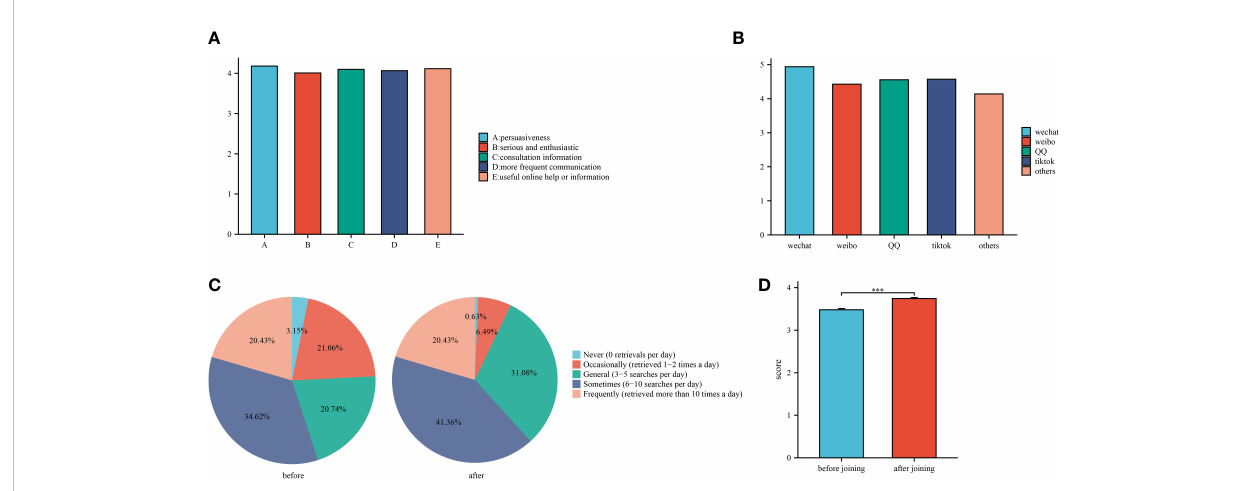
FIGURE 4 (A) : Scores for different online information exchange behavior; (B) : Score for different app usage frequency. (C) : Proportion of active search frequency before and after joining an online group. (D) : Average score of active search frequency before and after joining an online